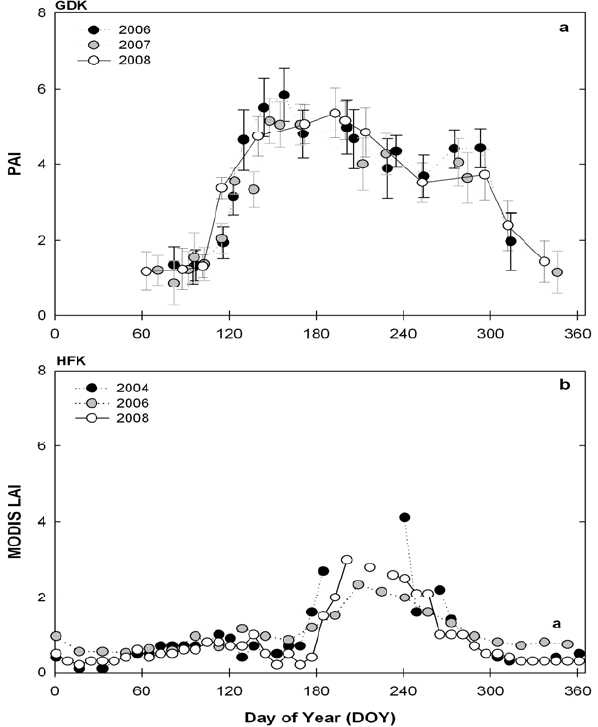
Fig. 4. Seasonal variation of Plant Area Index (PAI) at the GDK site (2006 to 2008) and Leaf Area Index (LAI) at the HKF site (2006 and 2008). Closed circles with a dotted line are for the GDK site measured from a plant canopy analyzer (LAI-2000) and the error bar indicates standard deviation of each measurement. Open circles with a dotted line are for the HKF site obtained from moderate- resolution imaging spectroradiometer